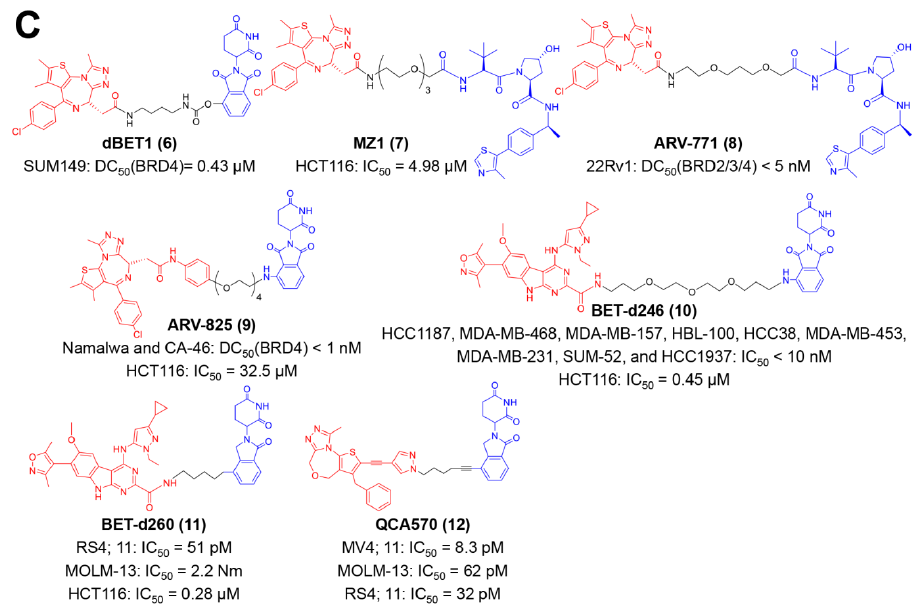
Figure 2. The chemical structures of representative PROTACs targeting the PD-1/PD-L1 checkpoint signal axis. ( A ) The chemical structures of representative PROTACs targeting PD-L1 protein. ( B ) The chemical structures of representative PROTACs targeting SHP-2. ( C ) The chemical structures of representative PROTACs targeting BET. DC 50 — half-maximal degradation concentration; IC 50 — half-maximal inhibition concentration.